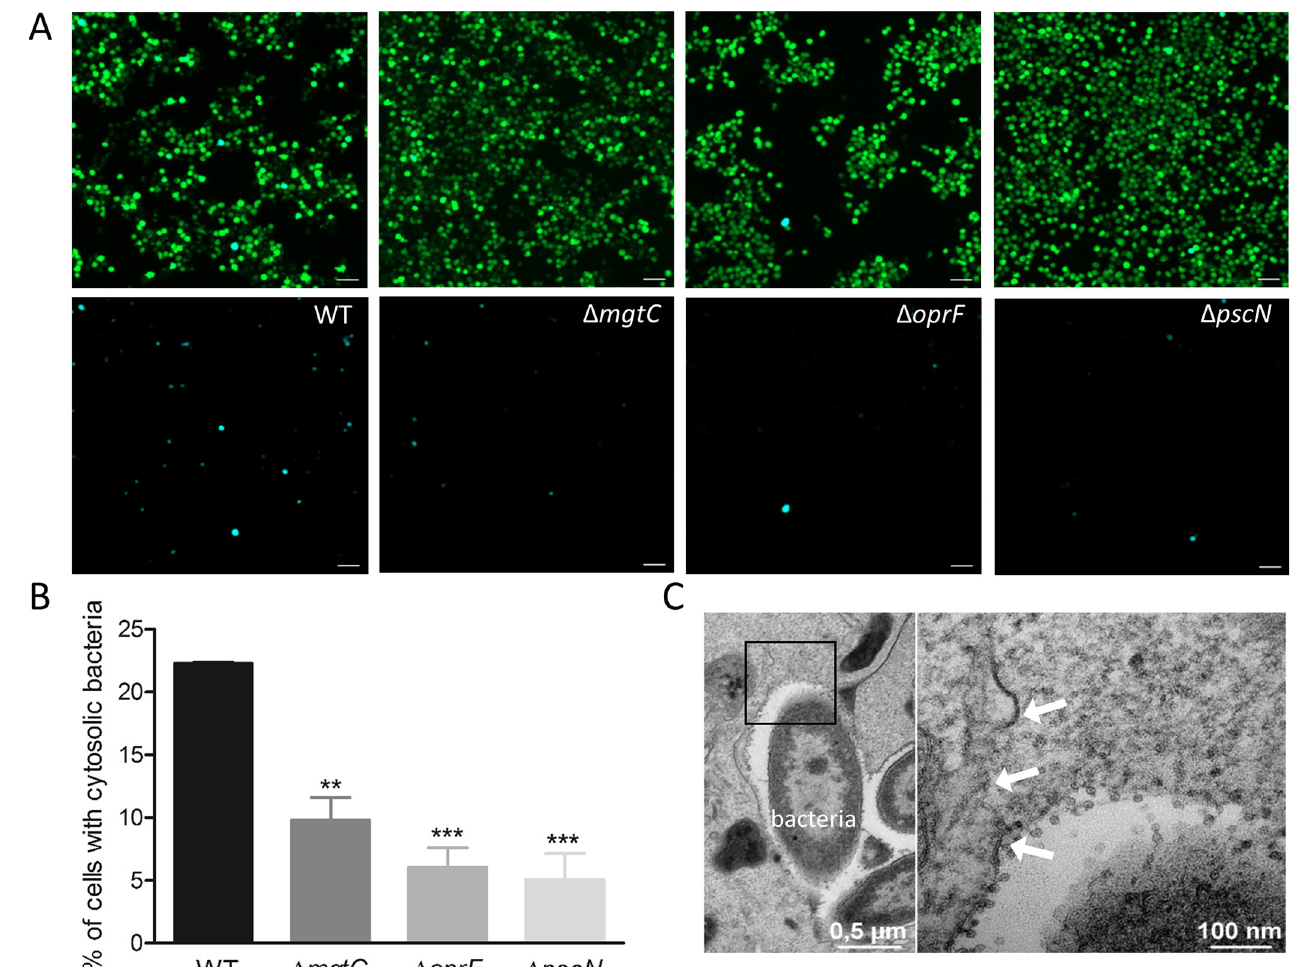
Fig 8. Assessment of access of P . aeruginosa to host cytosol using phagosome escape assay. J774 macrophages were infected with PAO1 WT, Δ mgtC , Δ oprF and Δ pscN strains. After phagocytosis, cells were stained with CCF4-AM in presence of gentamicin. 2 hrs post-phagocytosis, the cells were imaged with 10X objective using FITC and DAPI channels. Upon escape of bacteria from phagosome to the cytosol, the CCF4-AM FRET is lost, producing blue color. (A) Representative pictures are shown with the following channels: Total cell population is shown in merged green and blue cells, whereas cells with cleaved CCF4 probe are shown in blue in the lower panel. Scale bar is equivalent to 50 μ m. (B) Images were analyzed and quantified by Cell Profiler software to calculate the percentage of blue cells out of total green cells. At least 200 cells were counted per strain. Error bars correspond to standard errors from three independent experiments. The asterisks indicate P values (One way ANOVA, where all strains were compared to WT using Dunnett’s multiple comparison post-test, �� P < 0.01 and ��� P < 0.001), showing statistical significance with respect to WT. (C) Electron micrograph showing a disrupted vacuole membrane (white arrows) in a macrophage infected with PAO1 strain. The right panel shows higher magnification of the black square in the left panel.